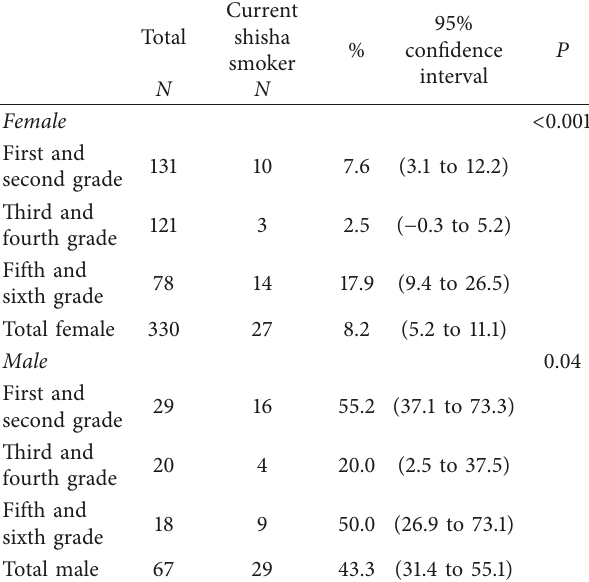
Table 5: Prevalence rate of current shisha smoking stratified by grade and sex.